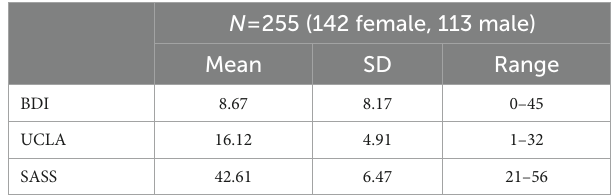
TABLE 1 Performance in self-report scales for Sample